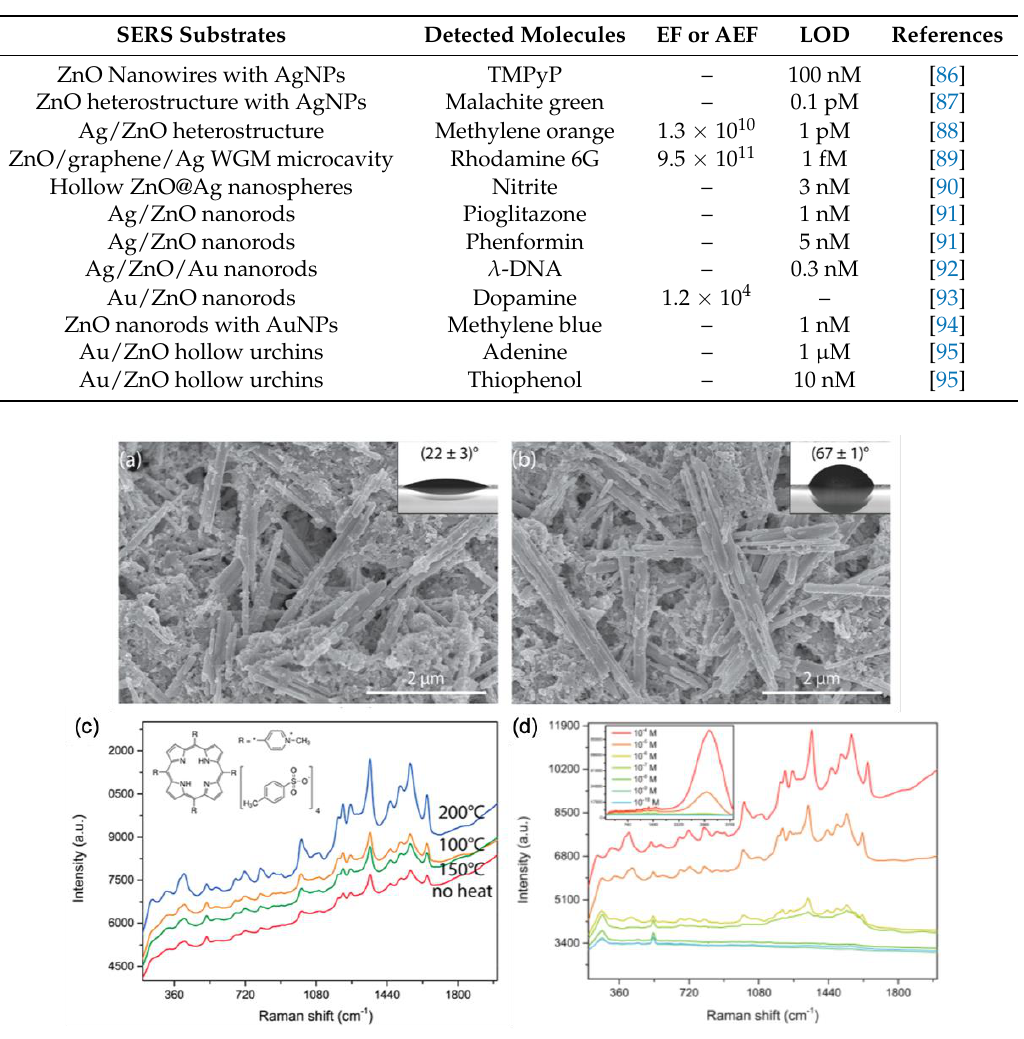
6. Figure 5. SEM pictures of ( a ) ZnO nanowires not annealed, and ( b ) annealed at 200 ◦ C. Insets display contact angles for each surface. ( c ) SERS spectra of TMPyP recorded on Ag/ZnO nanowires for several temperatures. ( d ) SERS spectra of TMPyP recorded on Ag/ZnO nanowires annealed at 200 ◦ C for various concentrations of TMPyP. Inset in ( d ) displays the whole spectrum with fluorescence signal that appears when the concentration is superior or equal to 10 − 5 M. All the figures are reprinted (adapted) with permission from [86], Copyright 2020 American Chemical